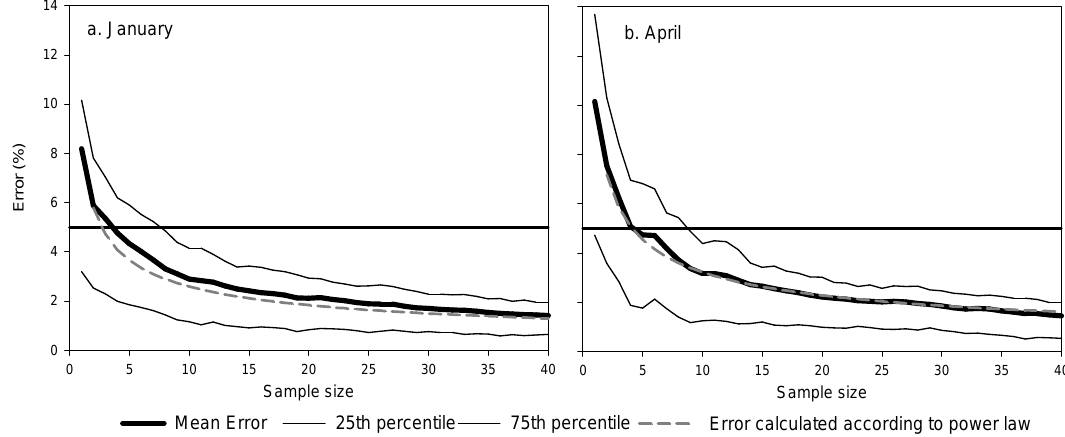
Figure 4 5 Fig. 4. Decrease in snow depth estimation error at the plot scale for various sample sizes. The thick line is the average error, and the thin lines are the 25th and 75th percentiles obtained from 50 replications. The grey dashed line is the error calculated according to a power law.